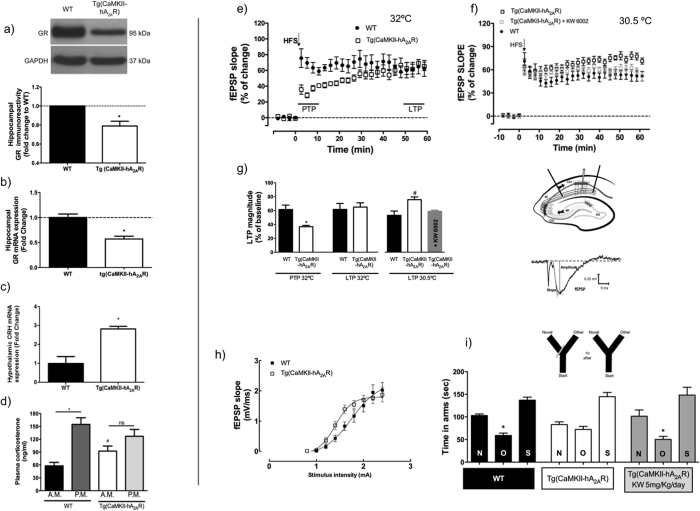
Neuronal overexpression of adenosine A2A receptor (A2AR) disrupts HPA-axis function.(a) GR protein and (b) mRNA levels are decreased in the hippocampus (n = 5) of Tg(CaMKII-hA2AR) compared to WT animals, and (c) CRH mRNA levels are increased in the hypothalamus (n = 5) of Tg(CaMKII-hA2AR) compared to WT animals, calculated using a unpaired Student’s t-test. (d) Corticosterone levels evaluated at 8 AM and 8 PM are elevated in Tg(CaMKII-hA2AR) and do not oscillate in a circadian manner (n = 6–9); Results were analysed with a two-way ANOVA followed by a Bonferroni post hoc. *P < 0.05 compared to WT, #P < 0.05 compared with WT at AM. High frequency stimulation (HFS: 100 Hz, 1s) was used to evaluate synaptic plasticity in hippocampal rat slices according to scheme depicted in lower panel (f). (e) At 32 °C, Tg(CaMKII-hA2AR) animals present a lower post-tetanic potentiation (PTP) and no effect on long term potentiation (LTP). (f) At 30.5 °C, Tg(CaMKII-hA2AR) animals present higher LTP magnitude which was rescued by one-month oral administration of an A2AR selective antagonist, KW 6002 (5mg/Kg/day). LTP and PTP magnitudes were quantified in (g). *P < 0.05 unpaired Student’s t test, compared to WT; and are presented as mean ± SEM of (n = 6–11) experiments; #P < 0.05 using one-way ANOVA, followed by a Bonferroni post hoc and (h) Input/Output (I/O) curve corresponding to fEPSP slope evoked by different stimulation intensities (0.6 – 3 mA). There is a shift to the left in the curve from Tg(CaMKII-hA2AR) animals. (i) Short-term reference memory, using the modified Y-maze test. Impairments in Tg(CaMKII-hA2AR) animals were rescued by oral KW6002 administration (n = 10–16). Results were analysed with a one-way ANOVA followed by a Bonferroni post hoc and are presented as mean ± SEM of n experiments. *,#P < 0.05 compared to Novel (N) arm.